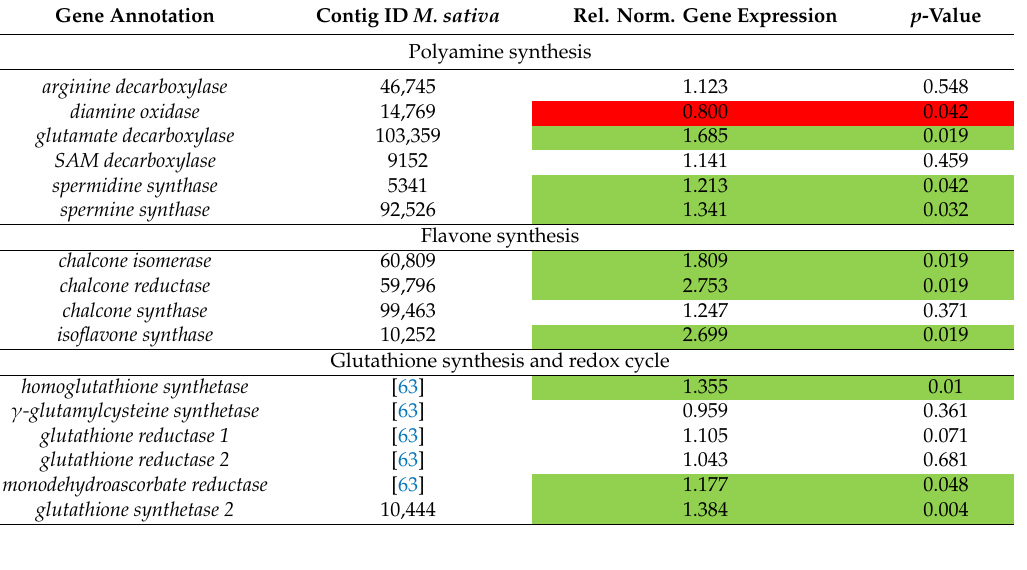
Table 1. Changes of normalized relative gene expression quantities in M. sativa stems upon cadmium (Cd) exposure. Normalized expression values are given relative to the control set at 1.00. Values are given as an average of 5 replicates. A t -test was performed to determine the significance ( p ≤ 0.05). Green significantly up-regulated; red significantly down-regulated.